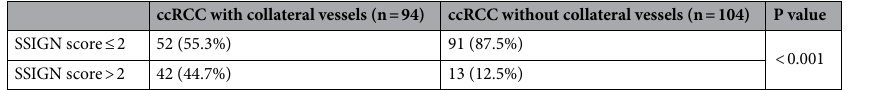
Table 2. SSIGN scores in ccRCC patients with and without collateral vessels. ccRCC clear cell renal cell carcinoma; SSIGN stage, size, grade and